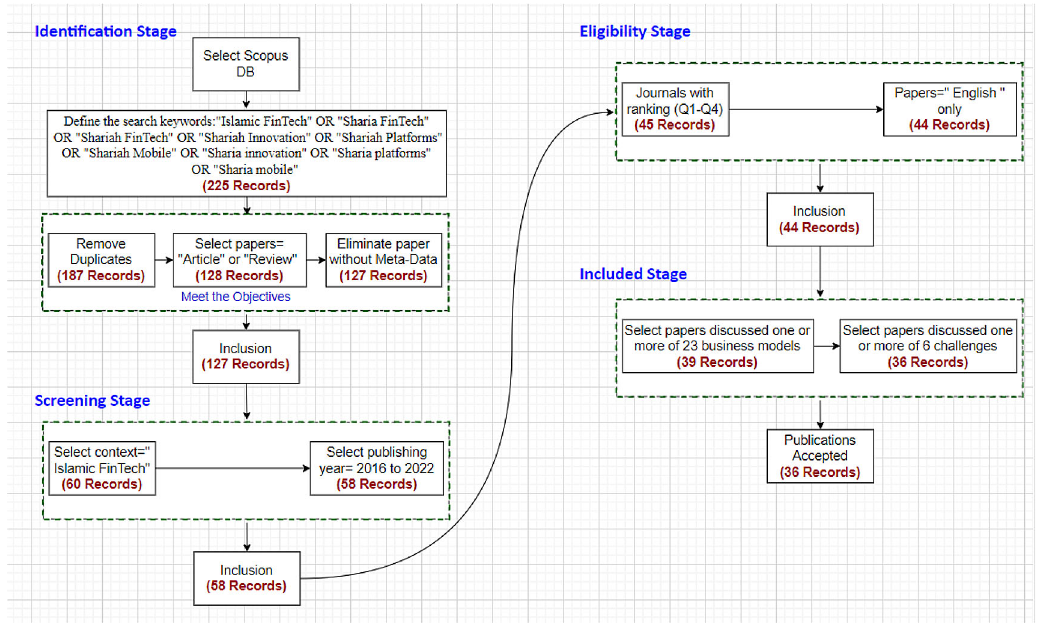
Figure 3. A systematic literature review. FinTech (financial technology); DB